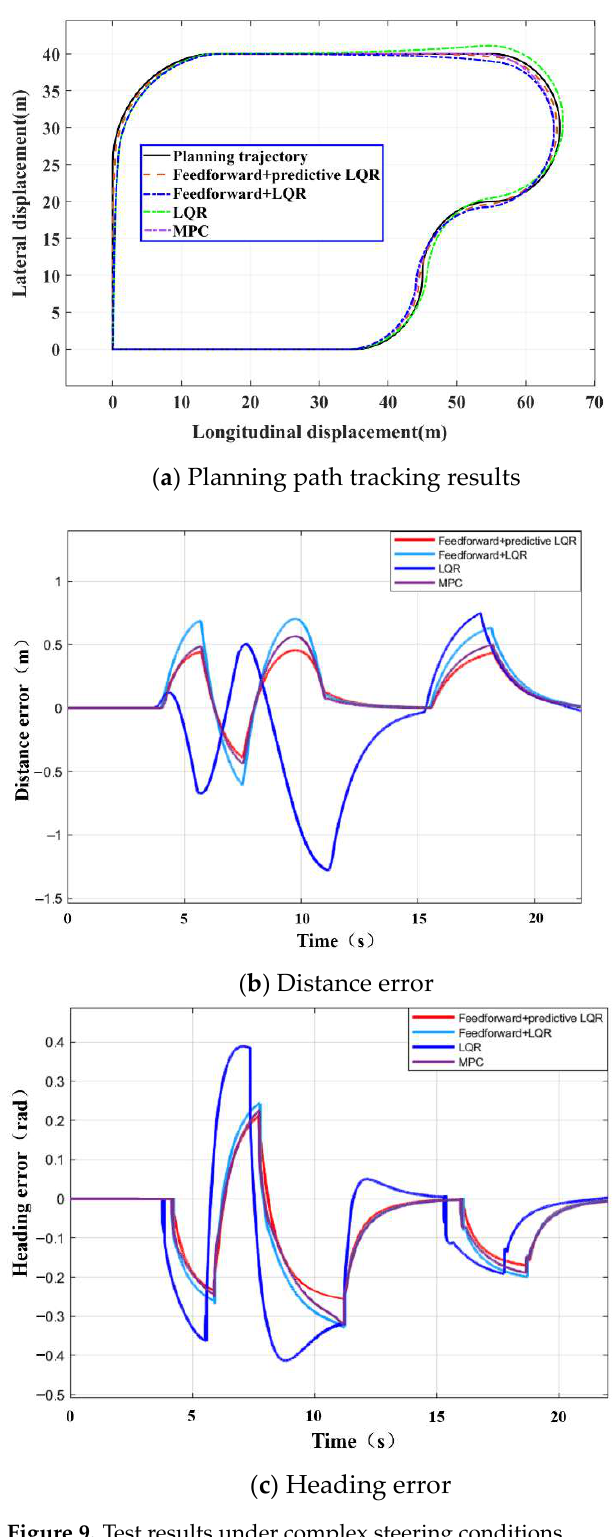
Figure 9. Test results under complex steering conditions.